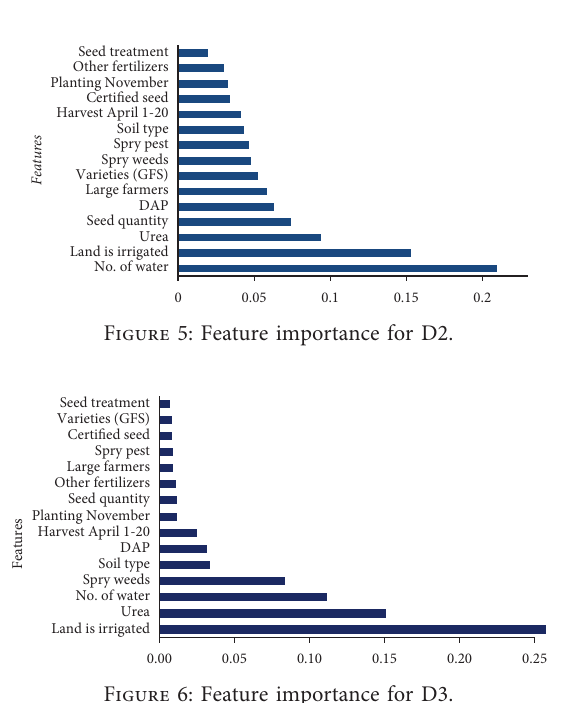
Figure 6: Feature importance for